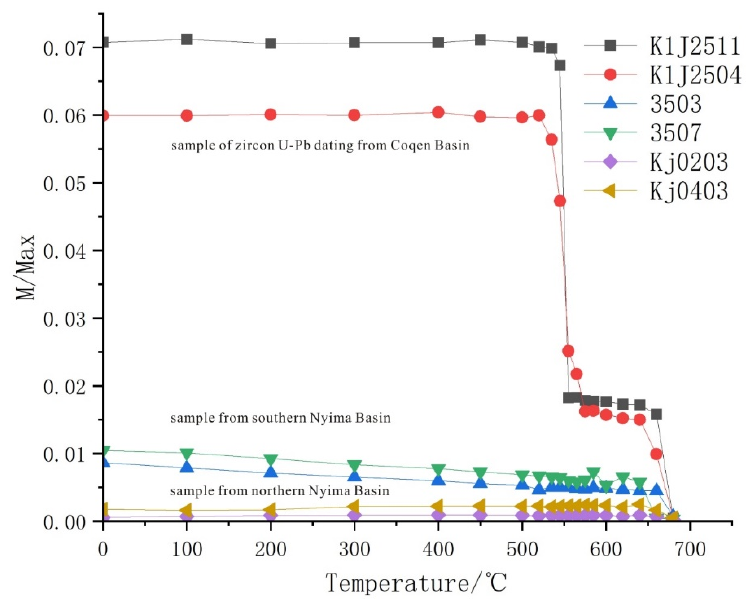
Figure 6. Curve of systemic thermal demagnetization for a typical sample in the Jingzhushan Formation of the Late